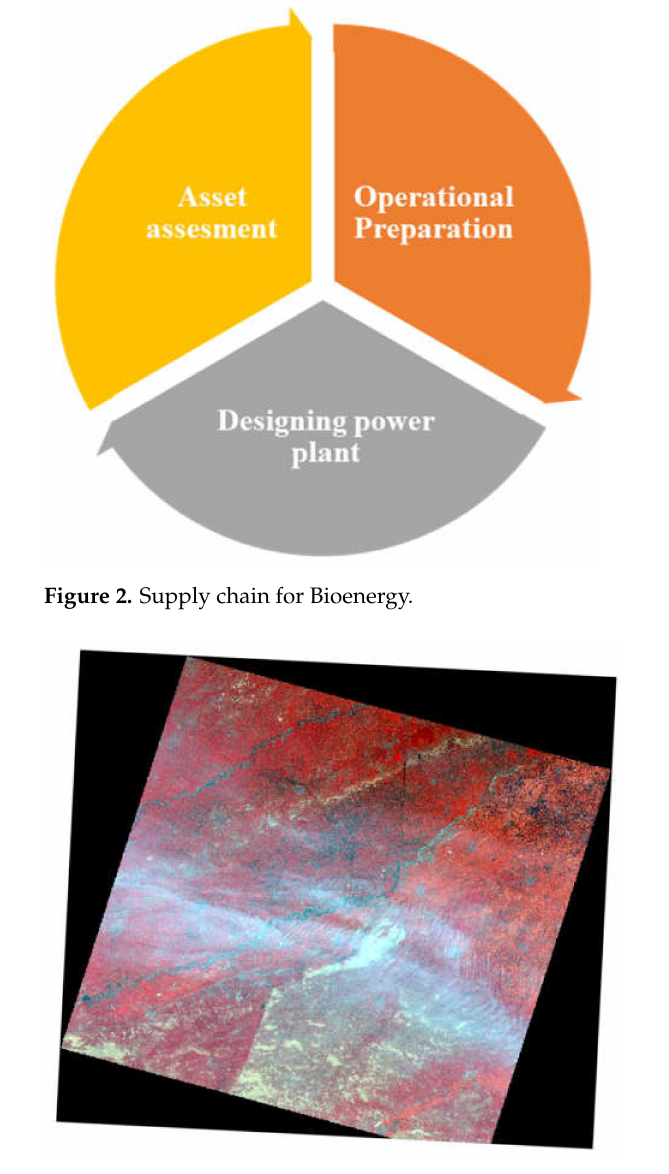
Figure 3. GIS image of study area (red color indicating healthier